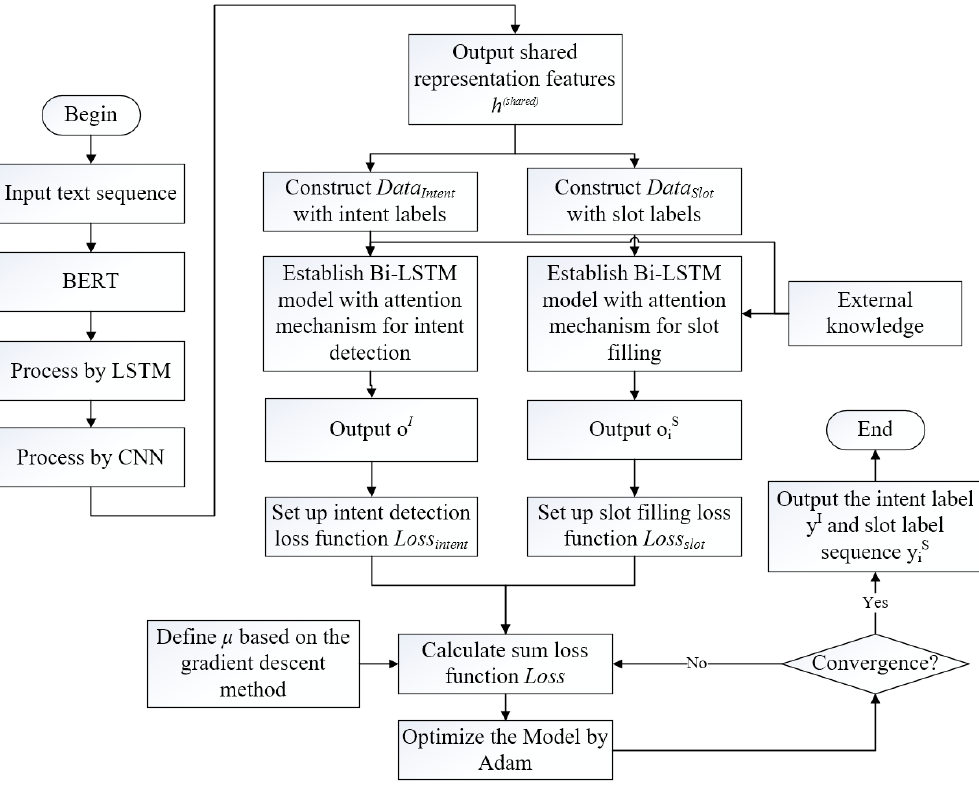
Figure 1. The flow chart of our model.